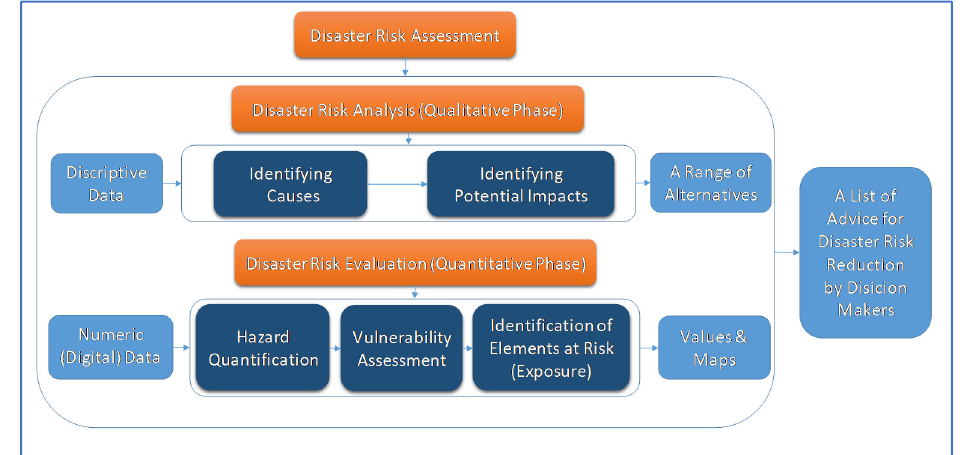
Figure 4. Disaster risk-assessment diagram.